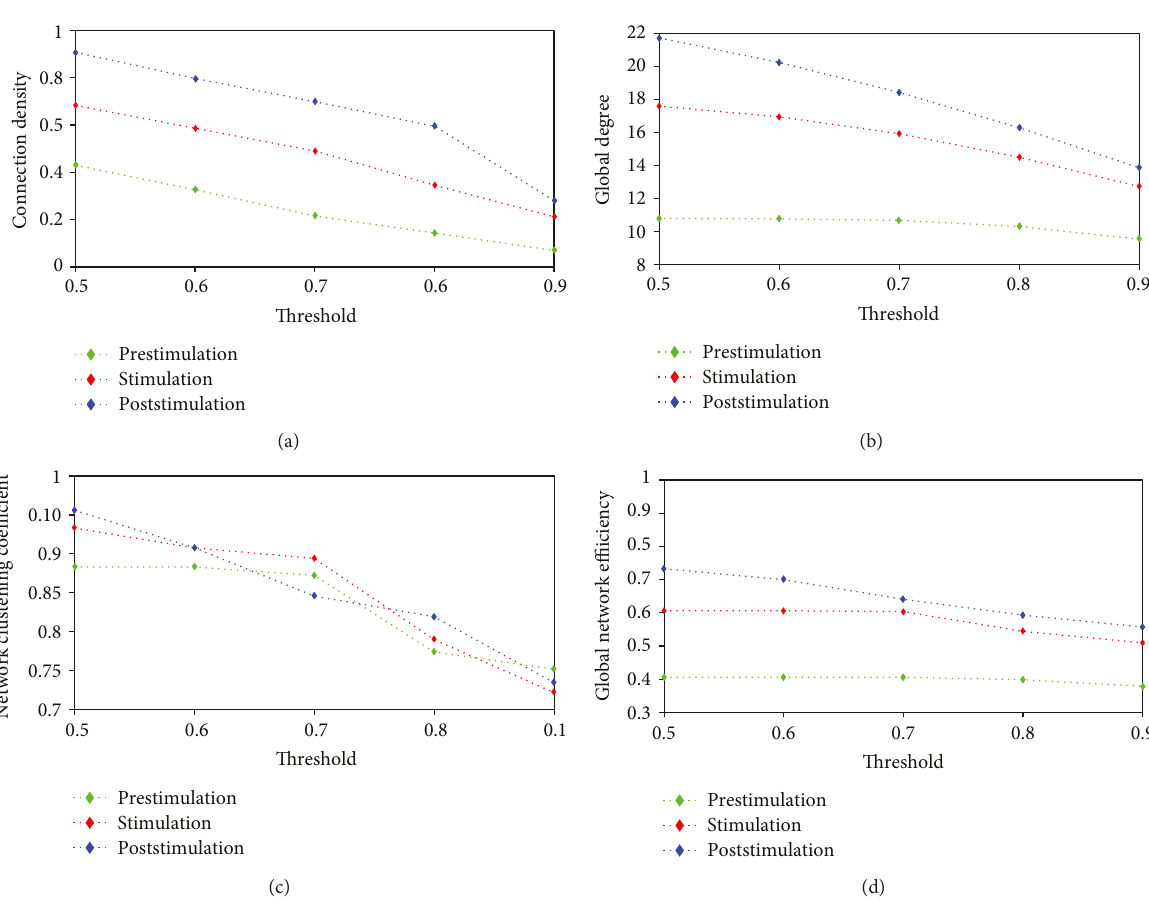
Figure 5: Global network metrics for all phases: (a) connection density, (b) degree, (c) clustering coe ffi cient, and (d) network e ffi